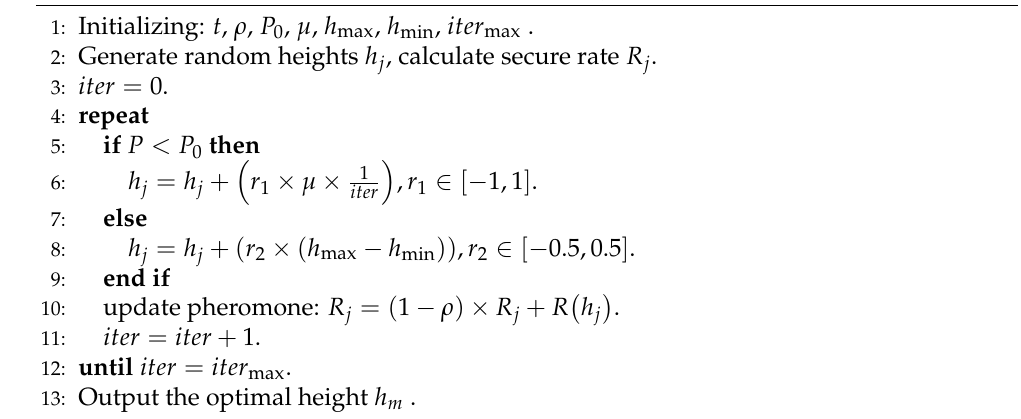
Algorithm 2 Height optimization based on ACO algorithm